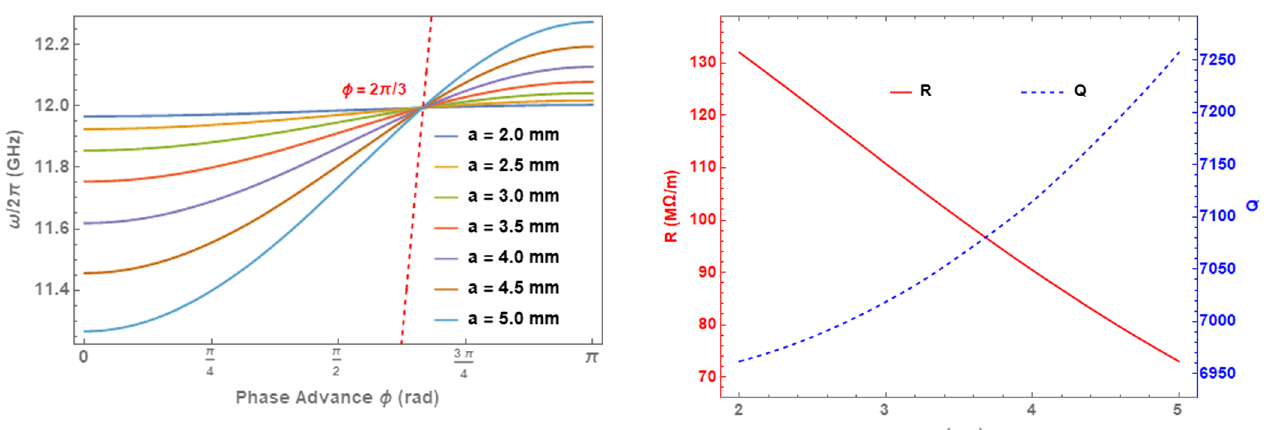
FIG. 4. The accelerating monopole dispersions for the base XARA cell for varying iris radii where the operating 2 π = 3 mode is tuned to 11.9942 GHz. The light line (LL) which represents the phase velocity of light is shown in dashed red.